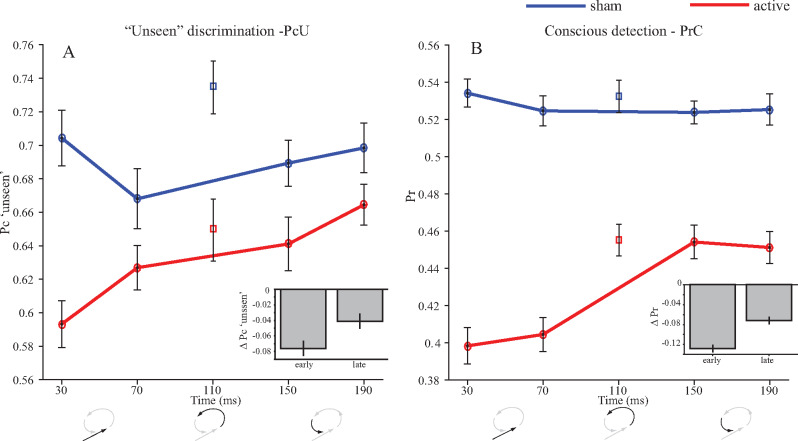
Illustration of group-level results for primary measures. Values on the abscissa denote TMS onset relative to stimuli onset. TMS applied at 110 ms is the BIP applied in isolation. All other pulses were applied in addition to the BIP. Panels A and B, the primary measures of ‘unseen’ discrimination (PcU) and conscious detection (PrC) and bar inserts collapse data across the early (30 and 70 ms) and late (150 and 190 ms) epochs, illustrating the data to which primary analyses were applied to test temporal order effects. Error bars are the within-subject standard error (Loftus and Masson 1994). Cartoon illustrations at the bottom of the panels indicate the periods most effected by the interventions, corresponding to those depicted in Fig. 1